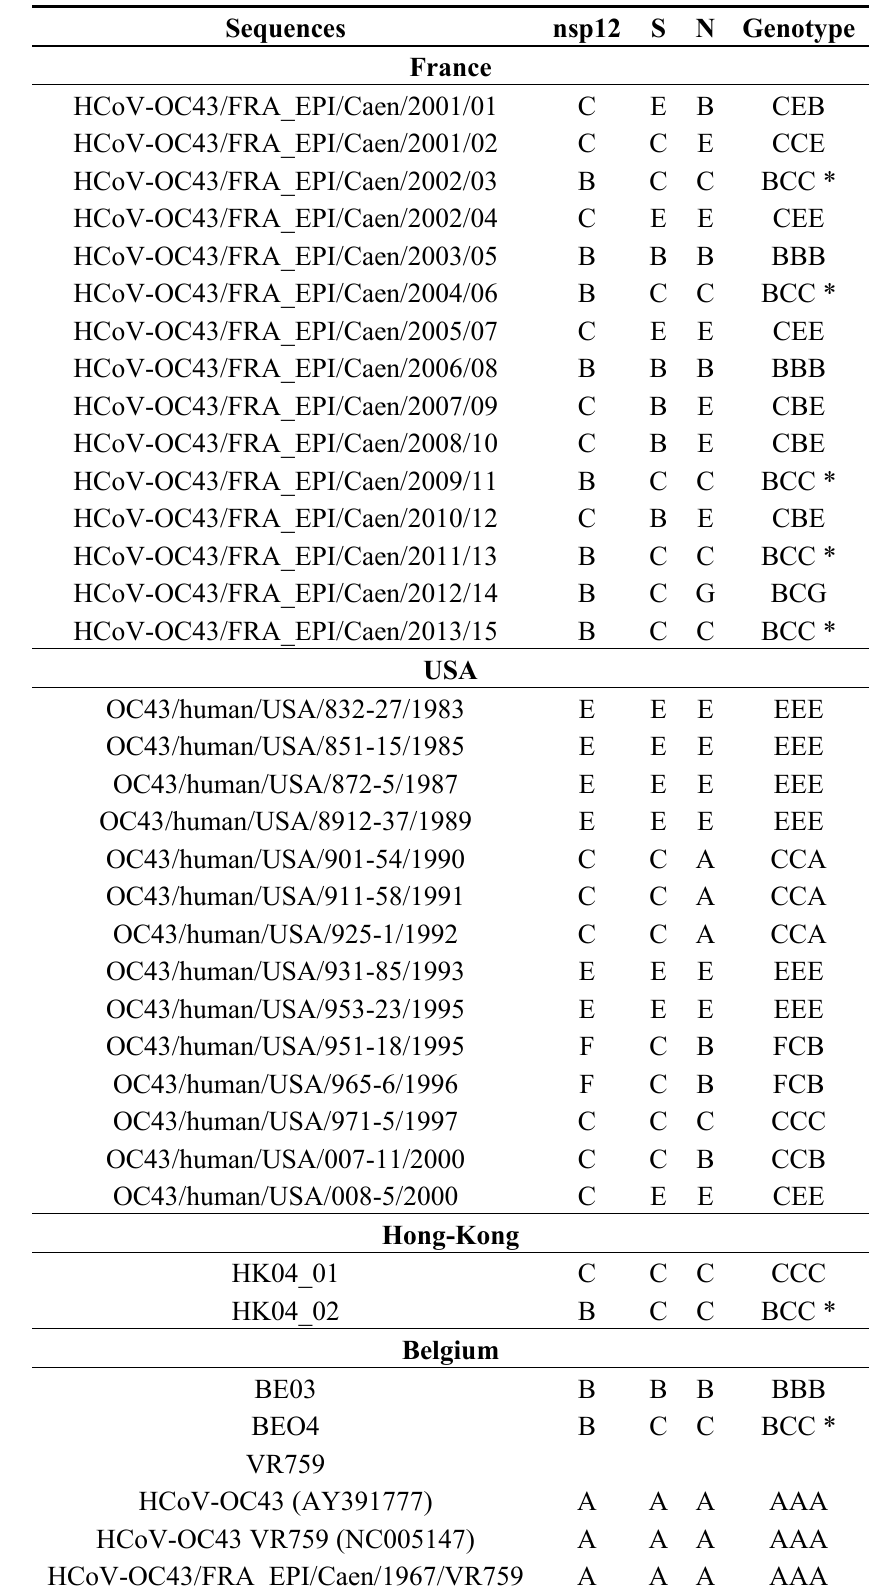
Table 2. Results of phylogenetic analysis of complete nsp12, S and N genes. * Genotype D, according to the definition from Lau et al.